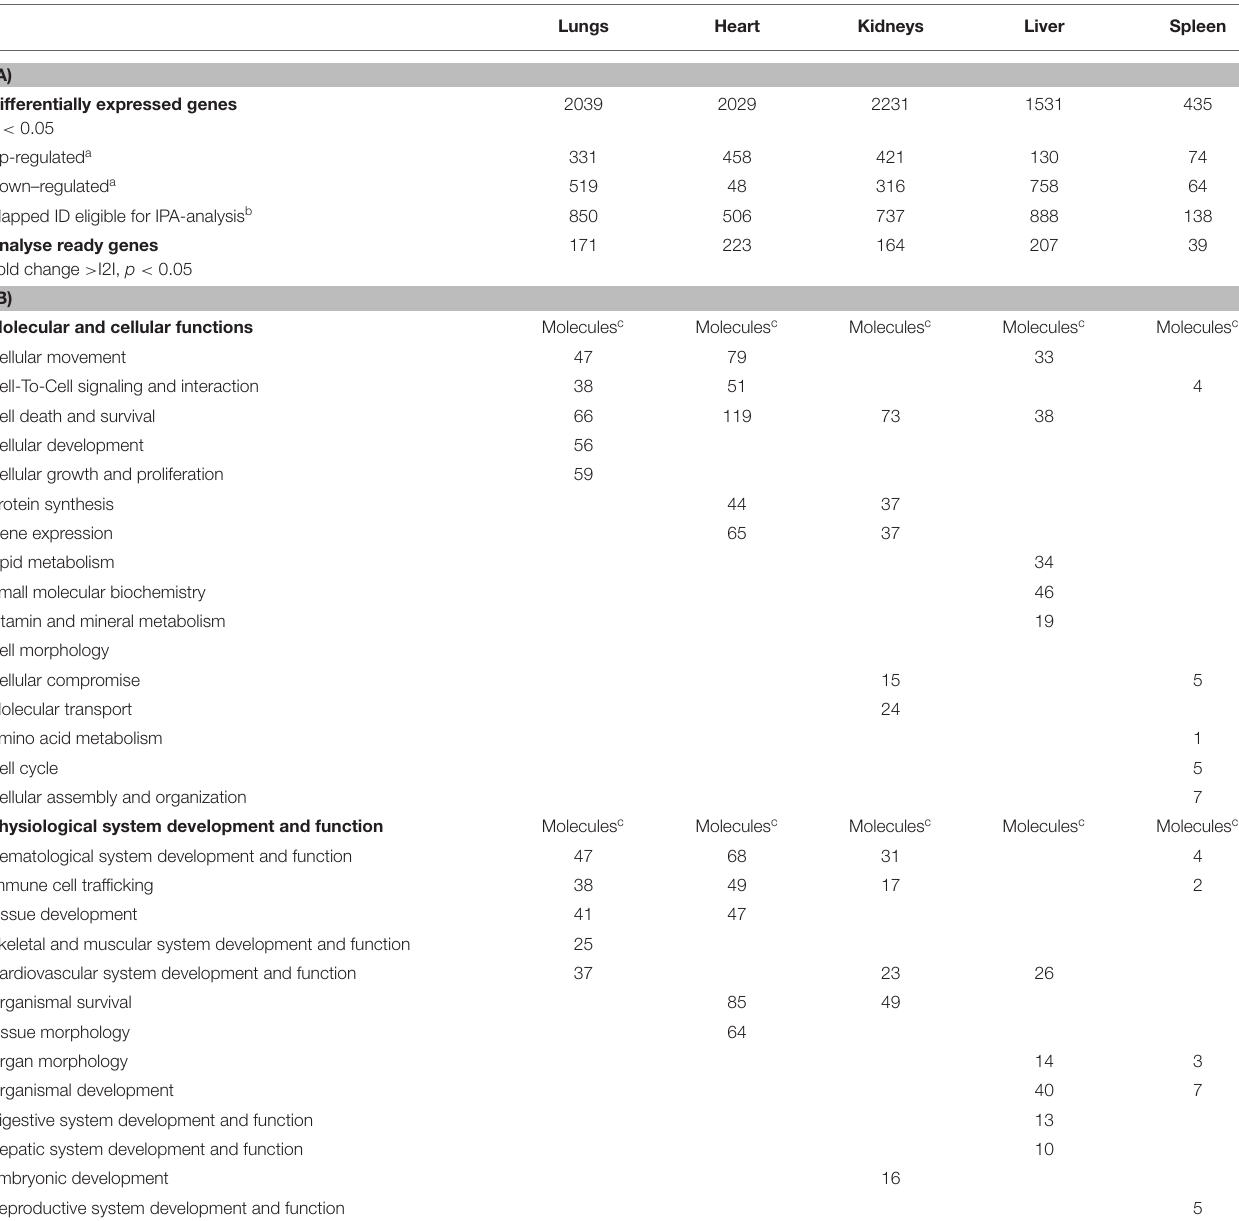
TABLE 4 | Numbers of genes differentially expressed (A) and functional analysis (B) in organs from patients with meningococcal septic shock ( n = 5) performed by IPA. Lungs Heart Kidneys Liver Spleen